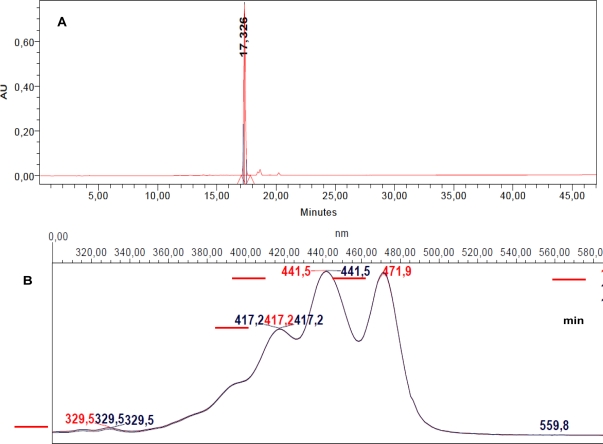
(A) RP-HPLC chromatogram of fraction F1.4 at 435 nm. F1.4 is mainly composed of a single molecule M eluting at t = 17.326 min; (B) Absorption spectrum of M at tr = 17.23, 17.33 and 17.50 min (peak start, peak maximum, peak end).